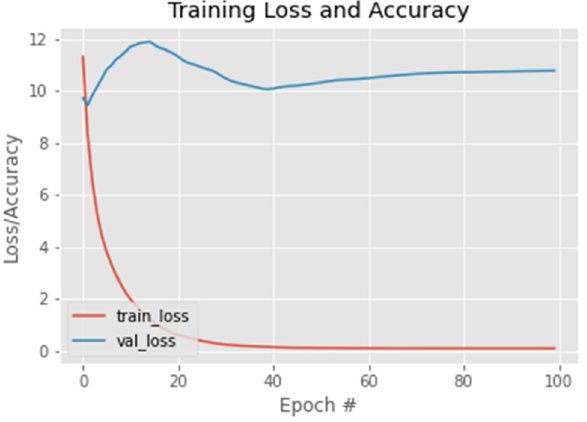
Figure 33. Training loss curve raised by MobileNet training using ImageNet-Sketch dataset.